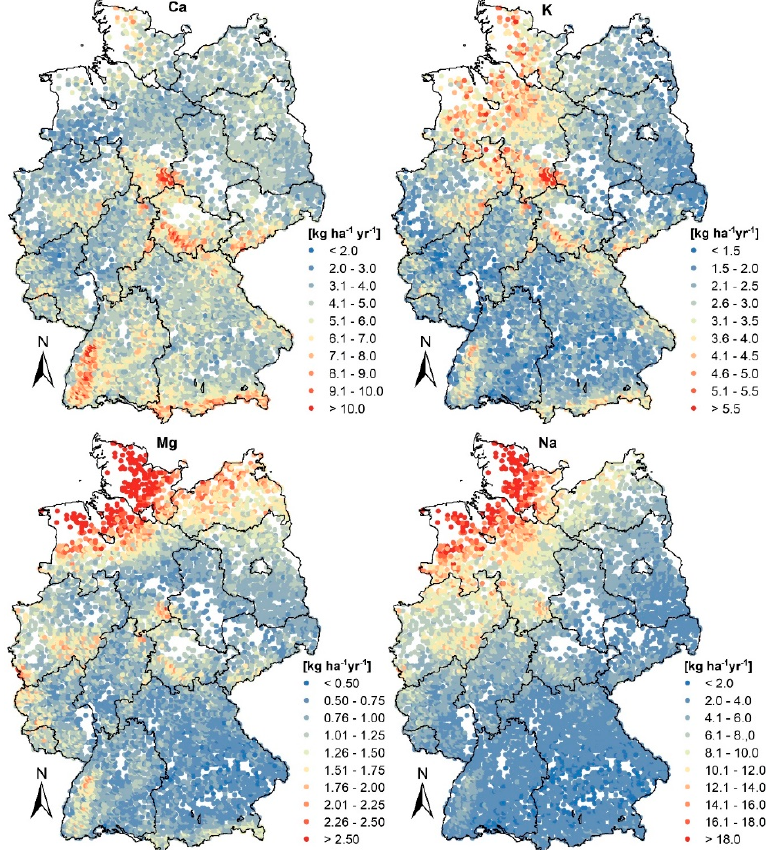
Figure A2. Regionalized atmospheric total deposition of the elements calcium (Ca), magnesium (Mg), potassium (K) and sodium (Na) at the tracts of the German National Forest Inventory (NFI).